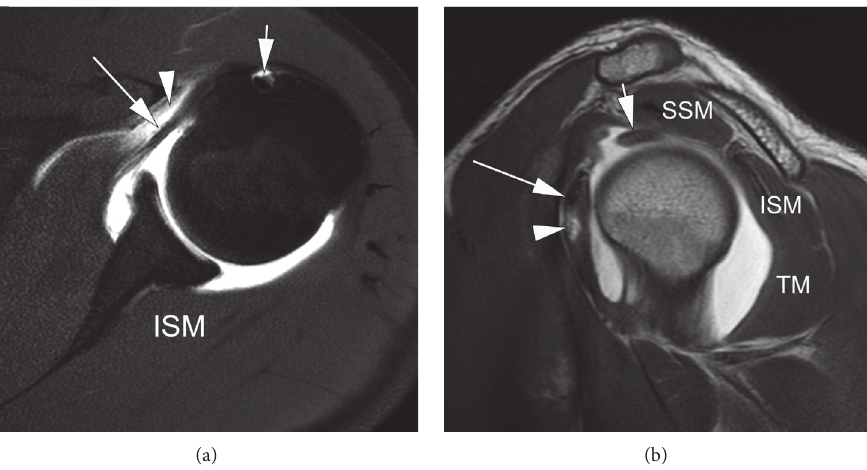
Figure 4: Normal MR arthrogram: axial T1-weighed FS (a) and sagittal T1-weighted (b) MRI show an intact subscapularis tendon (long arrow in a and b), long head of the biceps tendon (short arrow in a and b), supraspinatus muscle (SSM), infraspinatus muscle (ISM), and teres minor (TM). Note. In addition, there are some extra-articular contrast material deposition anterior to the subscapularis tendon (arrowhead in a) and minor contrast deposition within the musculotendinous junction of the subscapularis (arrowhead in b).